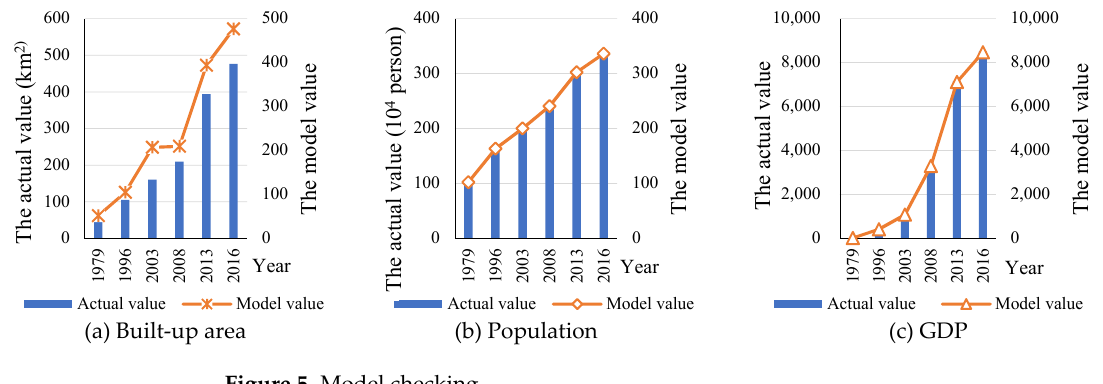
Figure 5. Model checking. Table 4. Total carbon emissions, carbon-emission intensity, per capita emissions and emissions per unit of land.